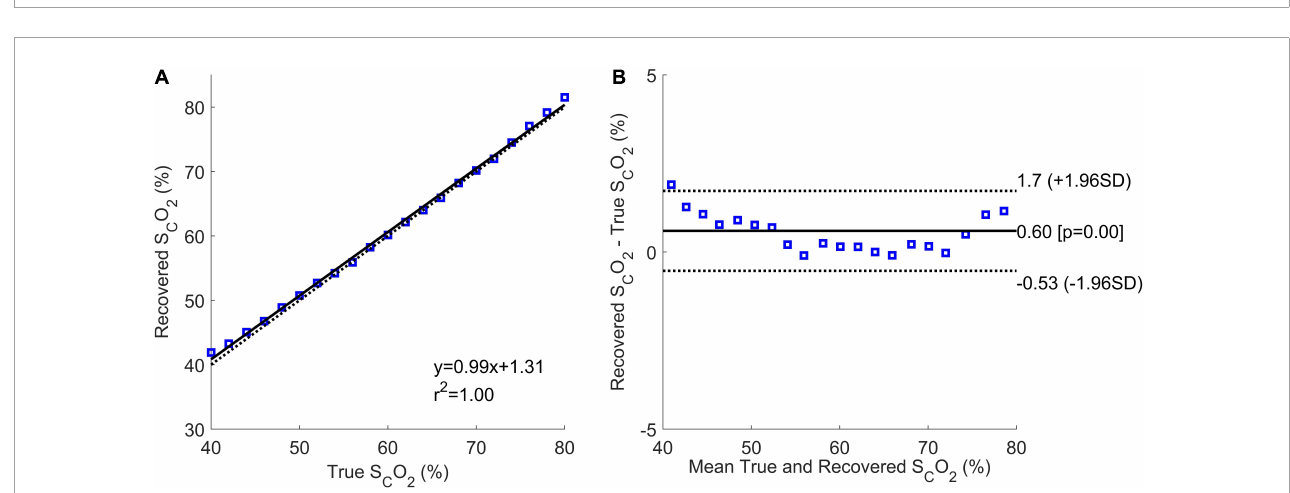
FIGURE7 Correlation (A) and Bland-Altman (B) plots of Phase 2 results. The correlation plot shows the estimated mean cerebral oxygen saturation for every true brain oxygen saturation (blue squares), the line of best fit (solid black line), and the expected values (dotted black line).